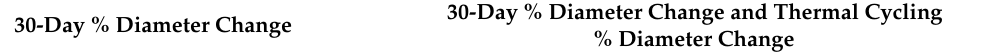
Table 10. Confusion tables for the logistic models that use day 1 microemulsion diameter to predict whether a microemulsion will meet the CQA specifications of thermal cycling diameter change and 30-day diameter change.